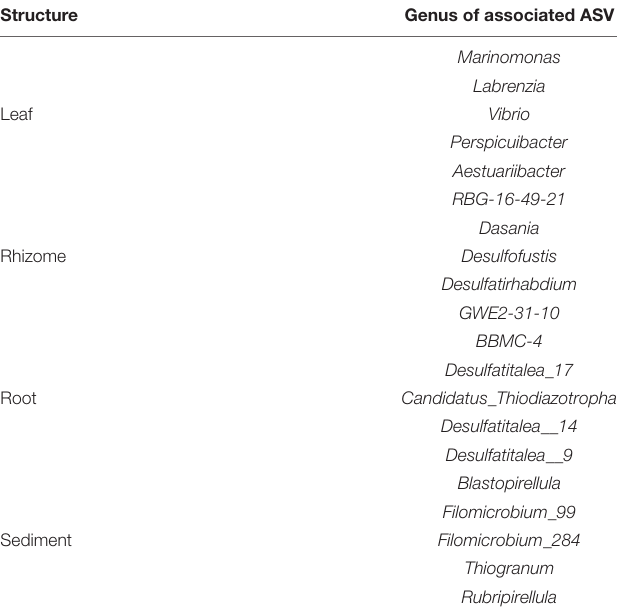
TABLE 3 | Top 5 genera significantly associated with the seagrass, Enhalus acoroides, at each location, see Supplementary Table 3 for a complete list of significant